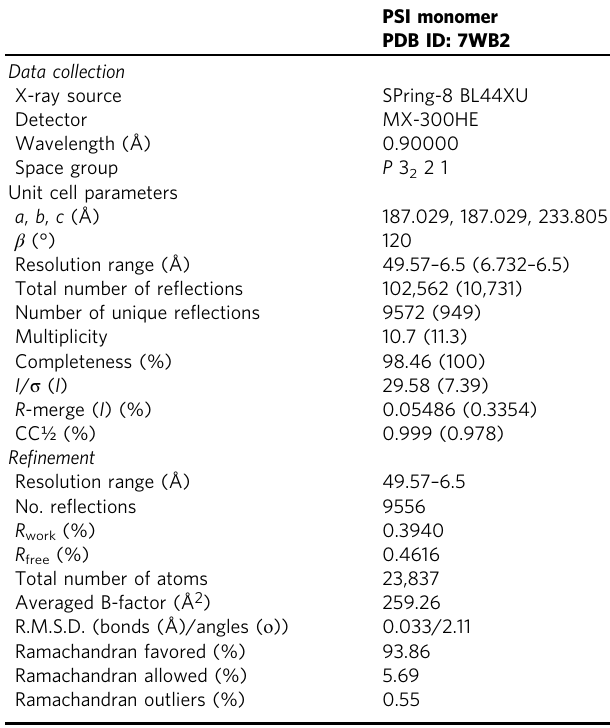
Table 2 Cryo-EM data collection, re fi nement and validation statistics.